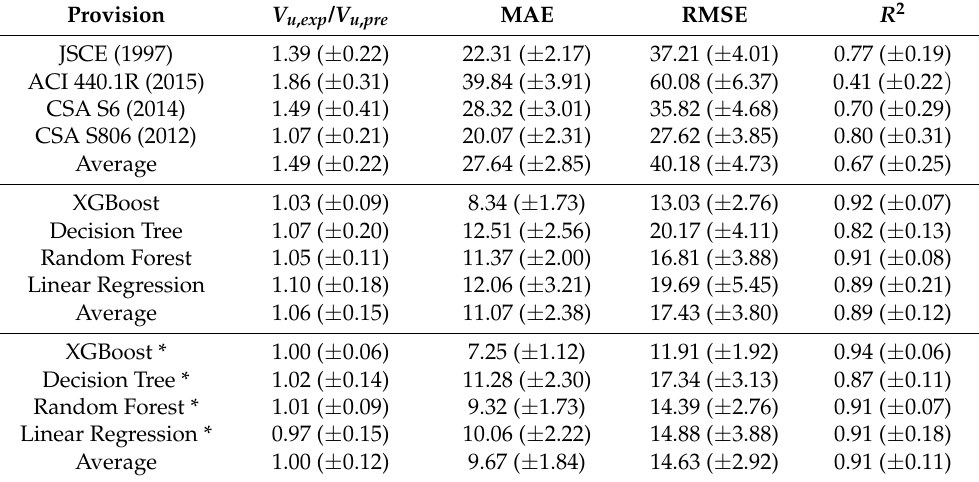
Table 4. Means and standard deviations of the statistical properties of Monte Carlo